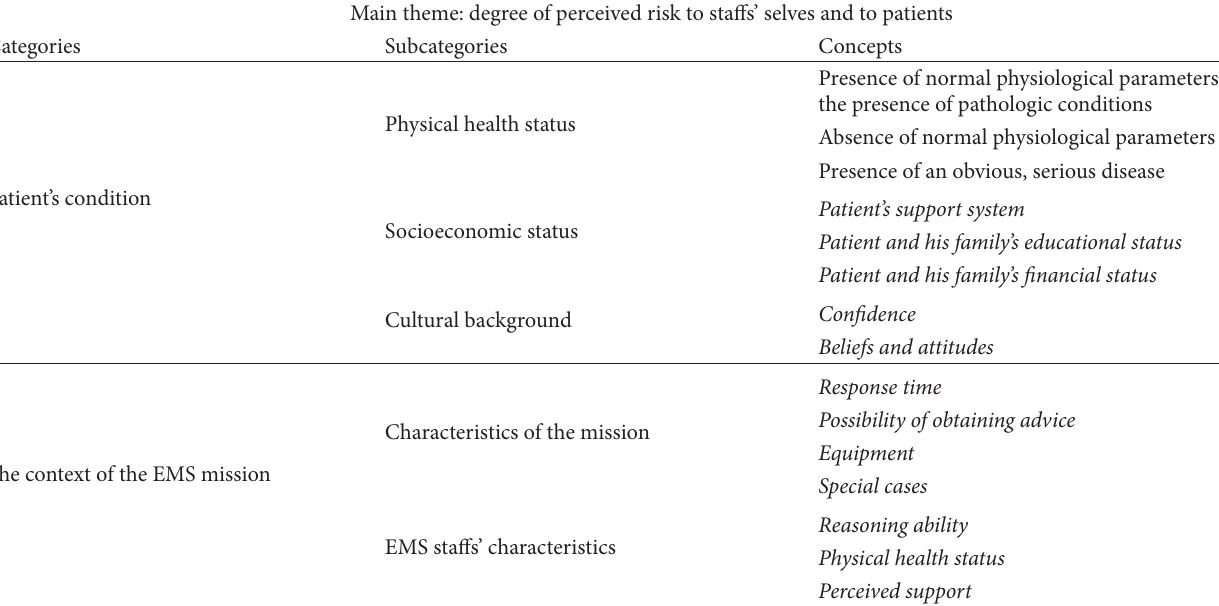
Table 1: Affecting factors of emergency medical services staffs’ decision about transporting medical patients to medical facilities. Main theme: degree of perceived risk to staffs’ selves and to